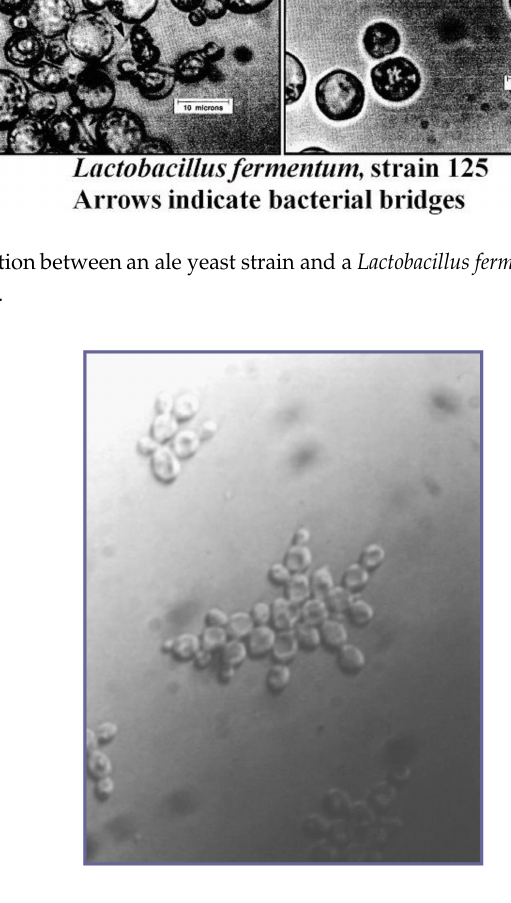
Figure 12. Chains of S. cerevisiae —pseudohyphae